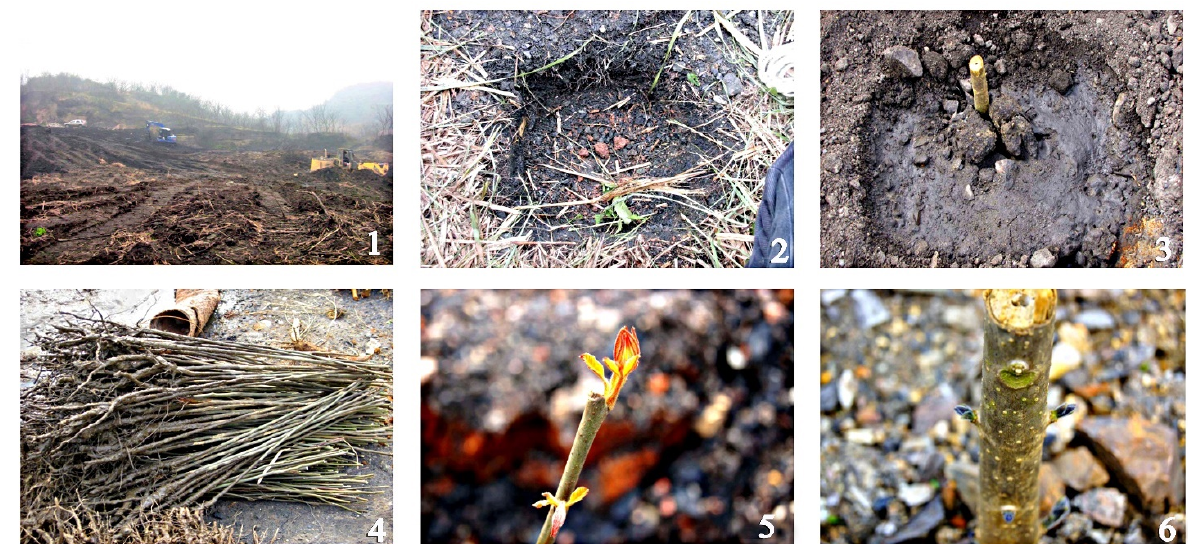
Figure 4. ( 1 ). Site cleaning. ( 2 ). planting hole. ( 3 ). ecological restoration plant. ( 4 ). ecological restoration plant. ( 5 ). Kolreuteria paniculate. ( 6 ). Paolownia fortunci.